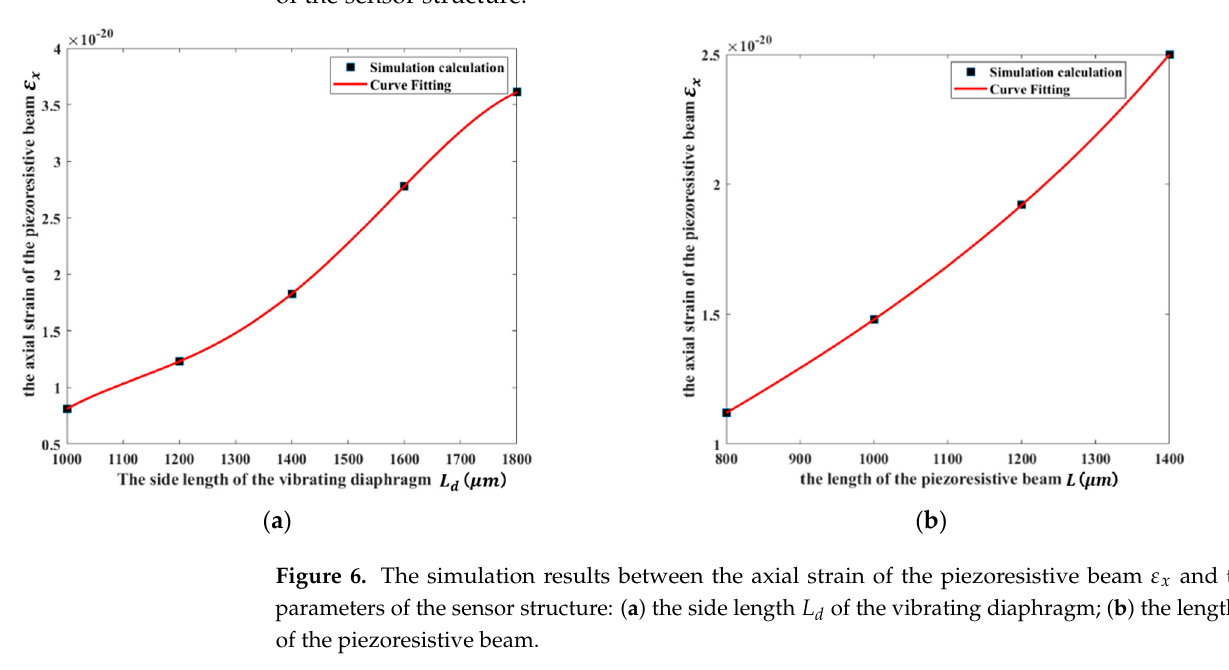
Table 1. The key parameters of the sensor. Key Parameters